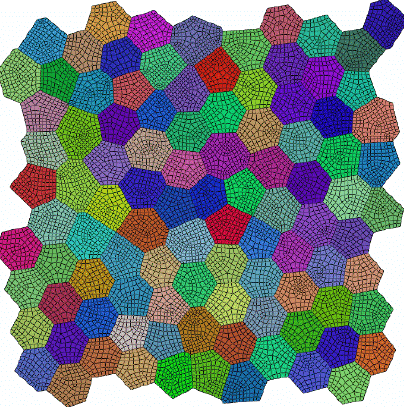
Figure 1. Illustration of mesh discretization of 100-grain RVE using DMG method.